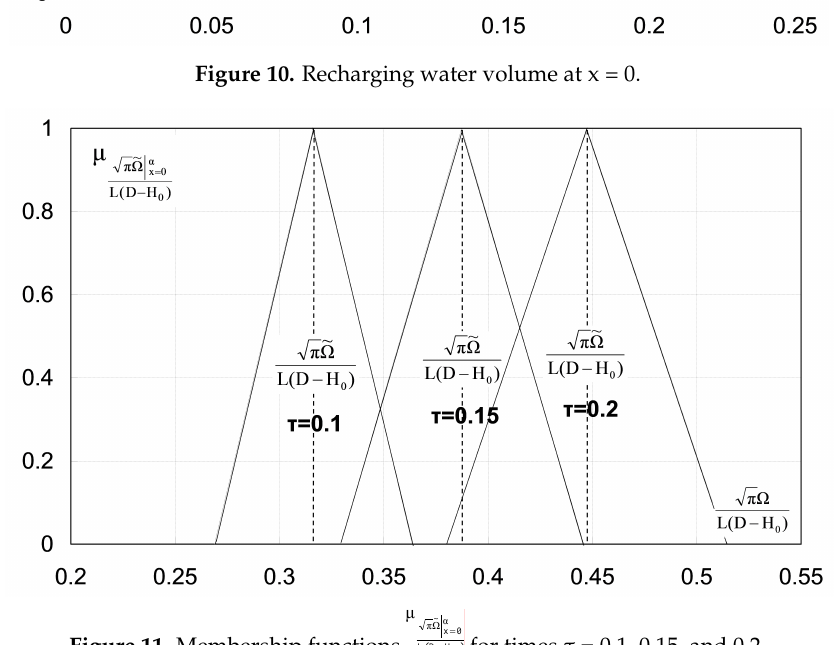
Figure 11. Membership functions µ for times τ = 0.1, 0.15, and 0.2.